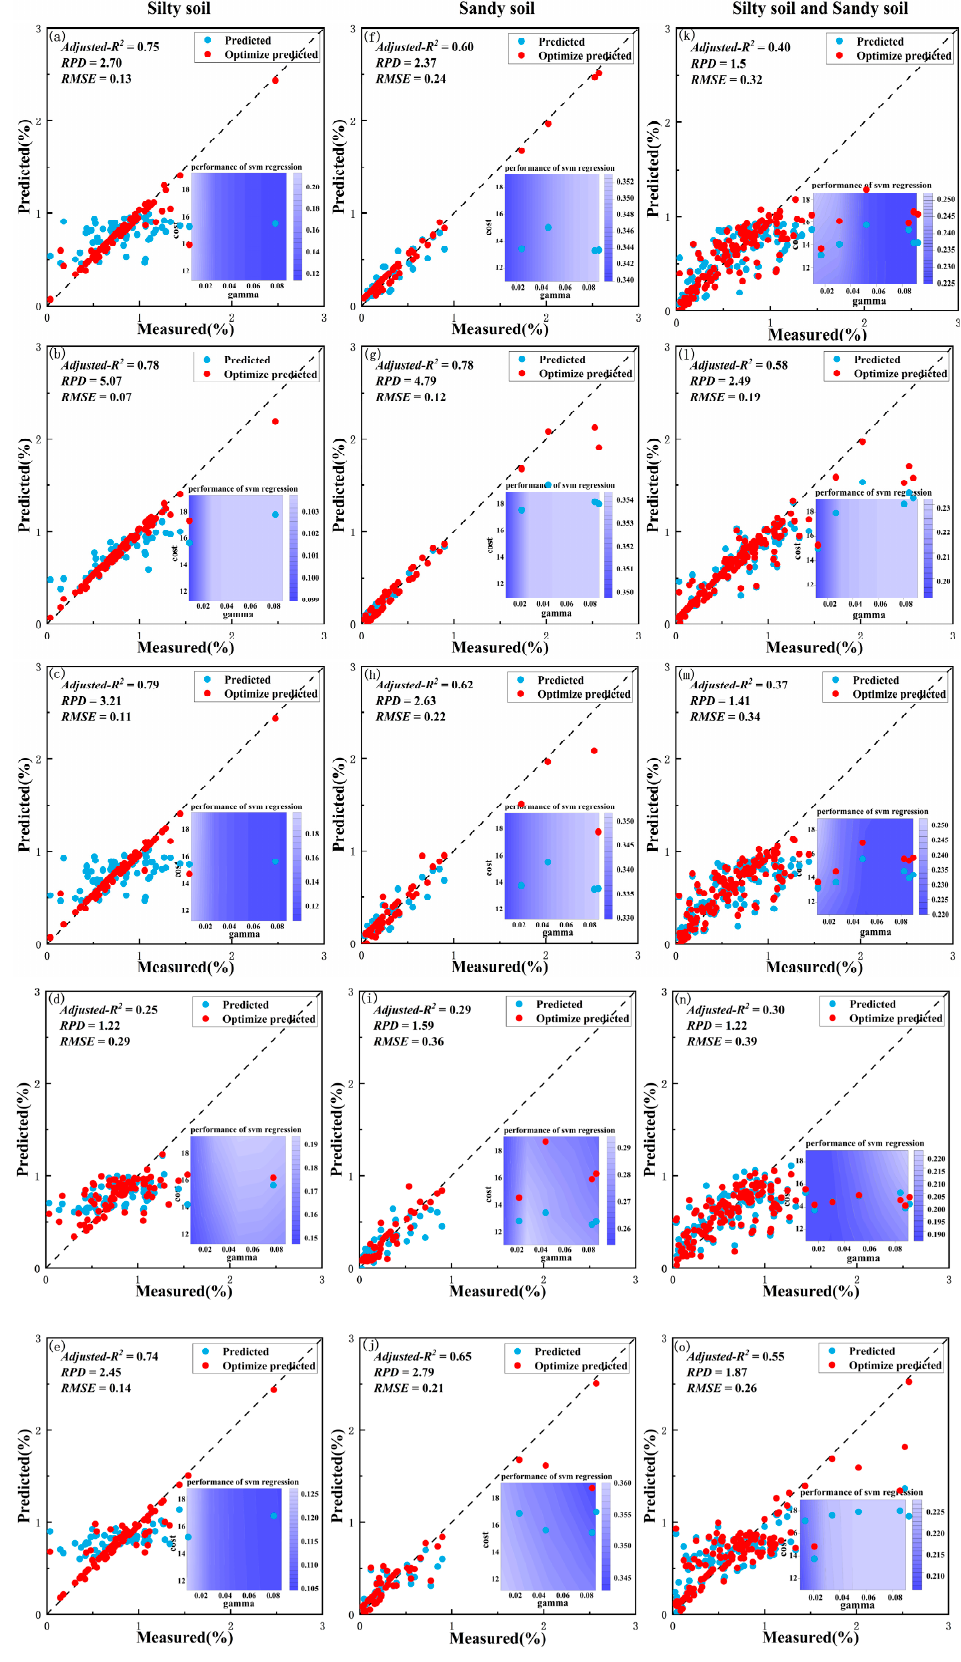
Figure 8. OSVR model results. ( a – e ) are silty soil; ( f – j ) are sandy soil; ( k – o ) are silty soil and sandy soil; the order was R, R (cid:48) , 1/R, log(1/R), and